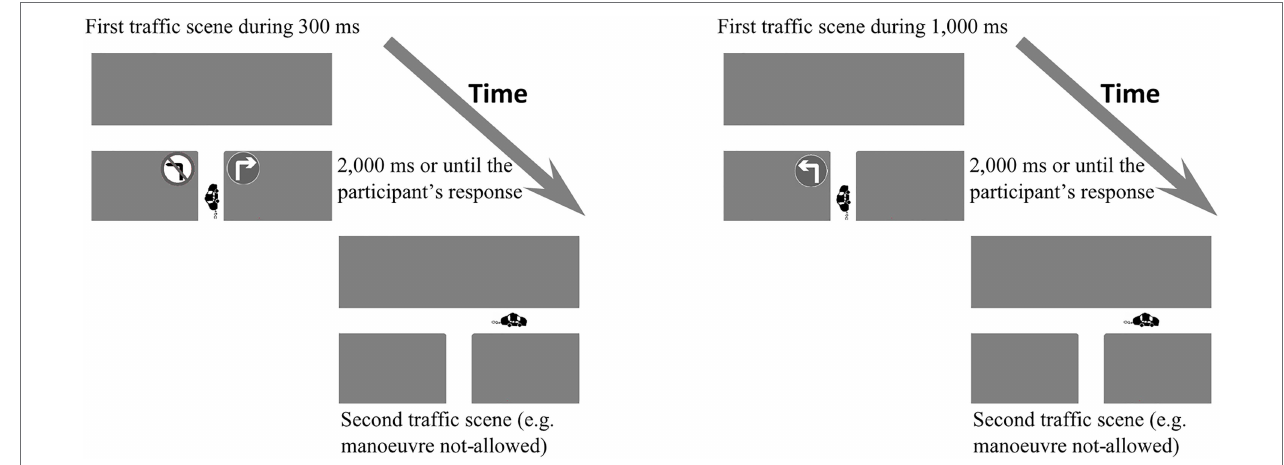
FIGURE 2 | Examples of the consecutive traffic scenes at a T-junction shown in Study